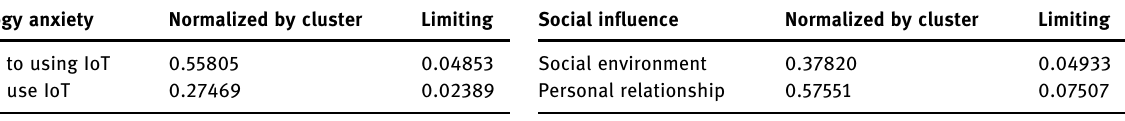
Table 5: Weight of technology anxiety sub - factor cluster Technology anxiety